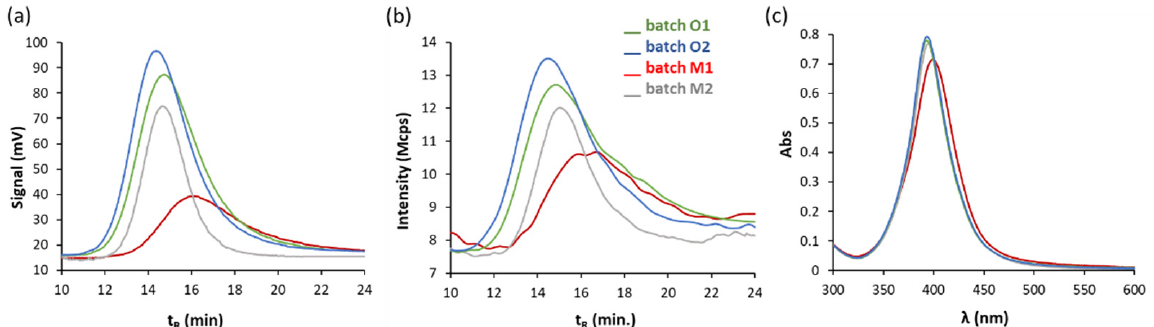
Figure 2. Fractograms obtained with ( a ) UV-Vis and ( b ) DLS detectors, and ( c ) UV-Vis spectra of dispersions diluted 1/4 with ultrapure water (5 mg·L − 1 ) of various commercial batches of AgNPs.